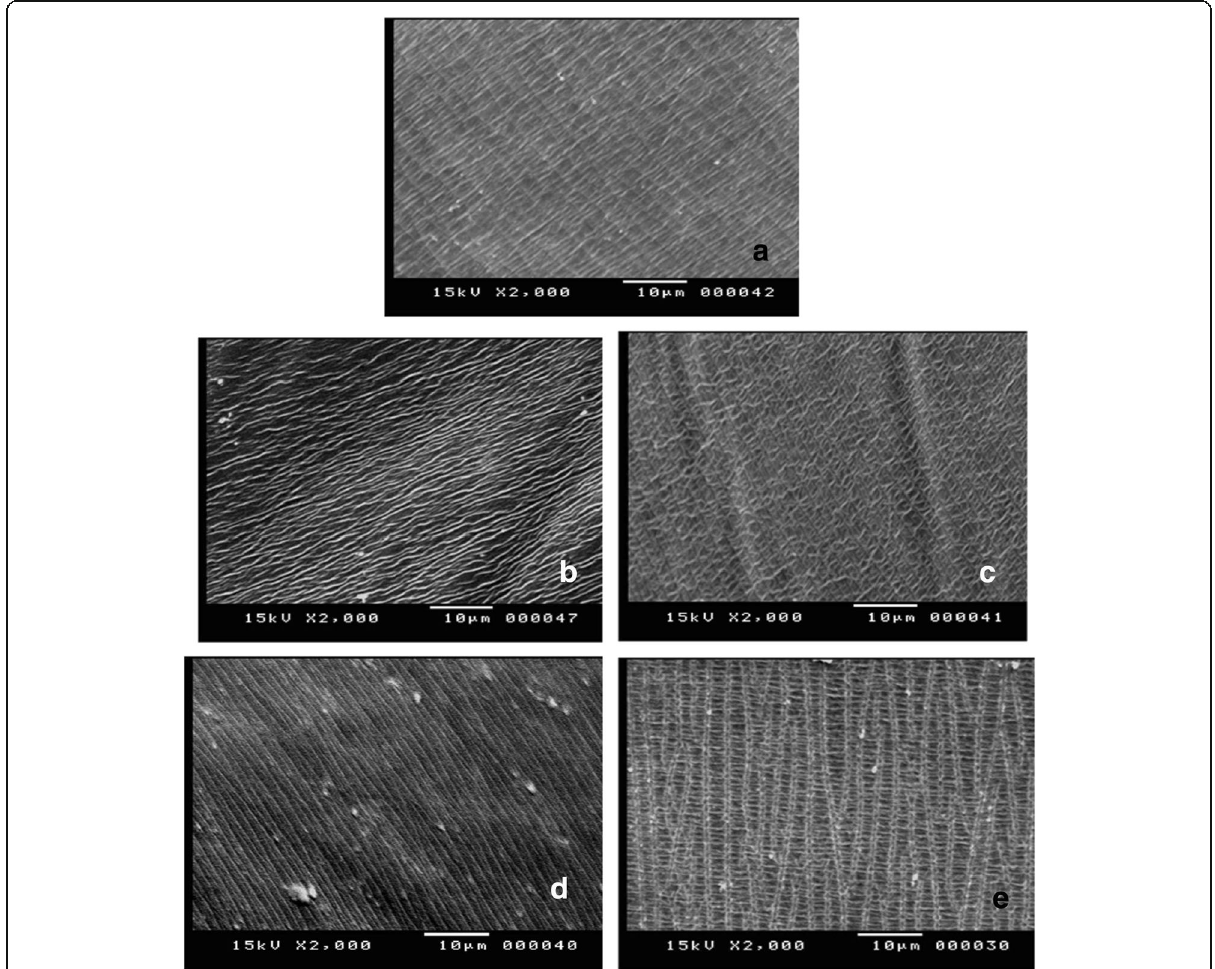
Fig. 4 Scanning electron micrographs showing the pattern of cuticular striations in: a larva collected from Oreochromis niloticus and Tilapia galilae ; b short form larva collected from Lates niloticus ; c long form larva collected from Lates niloticus ; d short form larva collected from Hydrocynus forskahlii ; e long form larva collected from Hydrocynus forskahlii